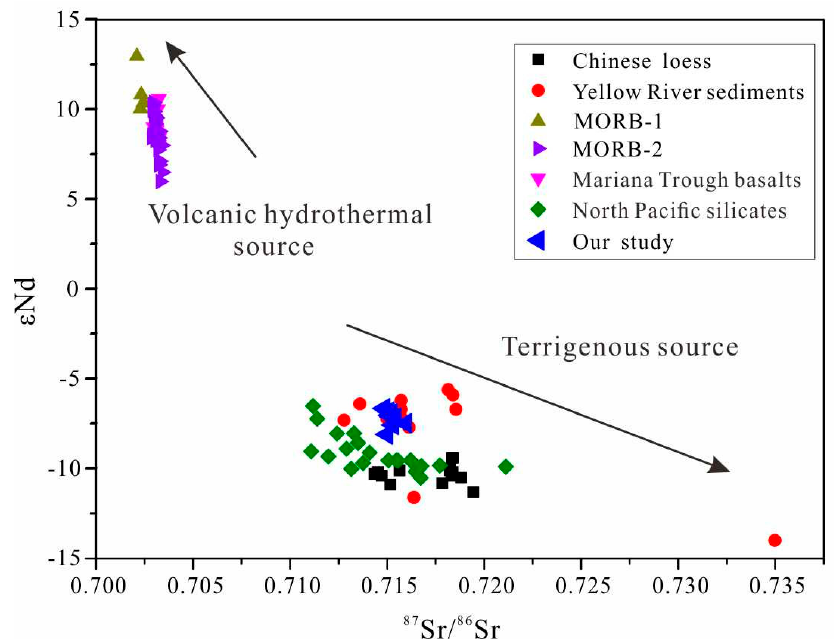
Figure 5. Sr-Nd isotopic compositions of GC1601 and other geological materials. Chinese loess data are from [49]; Yangtze River sediments data are from [50,51]; MORB-1 data are from [52]; MORB-2 data are from [53] Mariana Trough basalts data are from [54]; North Pacific silicates data are from [55].